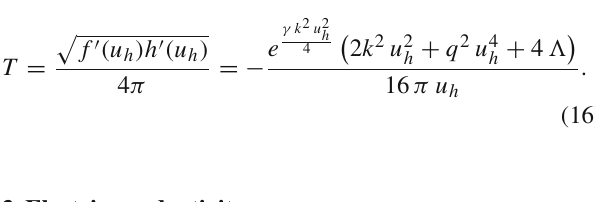
Fig. 1 DC conductivity σ DC as the function of temperature T for dif- ferent Horndeski couplings γ , where we set k = 1 / 2 and (cid:6) = − 3. And, there is a critical value which is γ = 1 / 3 beyond which the con- ductivity monotonously increases as the increases of the temperature. This figure has been firstly worked out in [41]